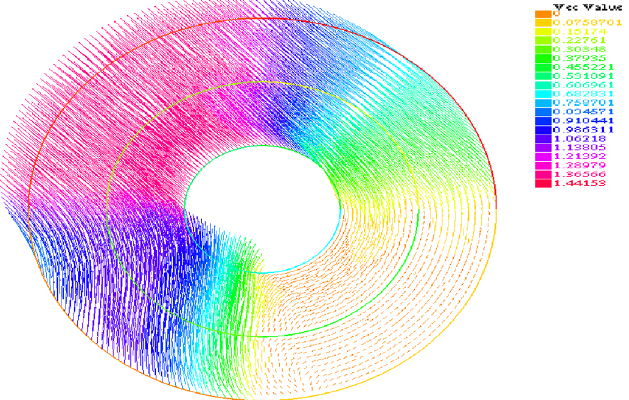
Fig. 2. First case with constraint of displacement u in direction w . Fig. 4. Case with constraint where the displacement u does not follow the direction w .